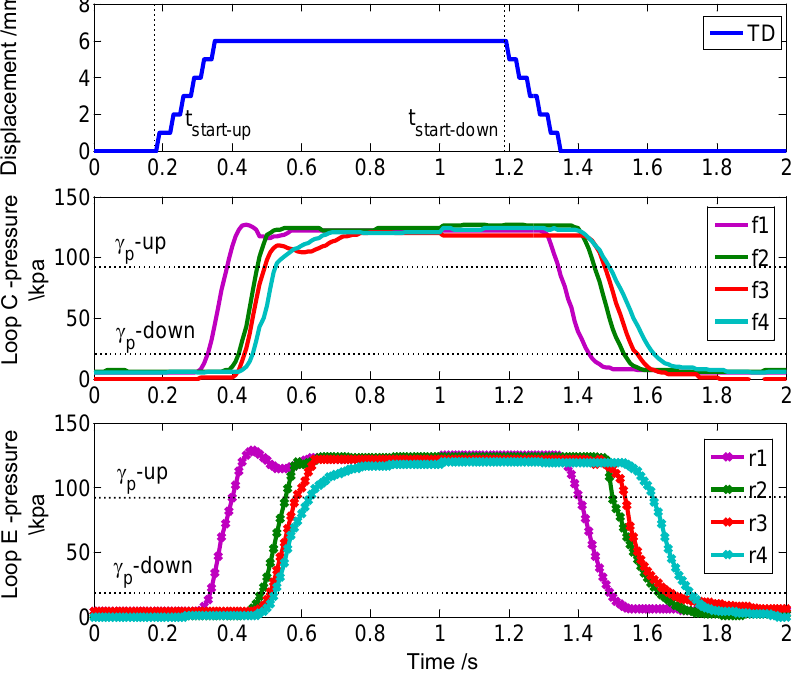
Figure 14. Original pressure curves of front loop C and rear loop E under the testing condition of group 1.